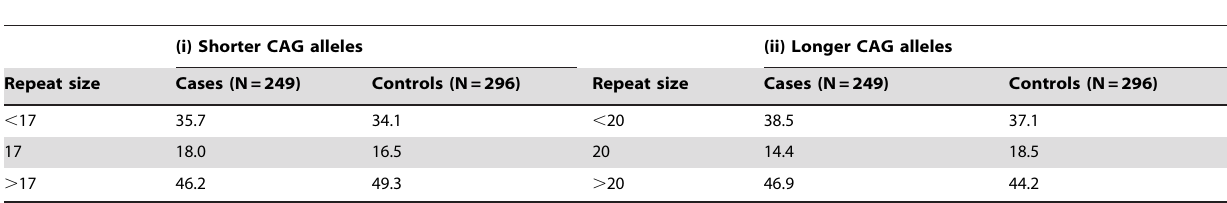
Table 2. Distribution (%) of PCOS cases and controls according to the qualitative categories of shorter and longer CAG repeats